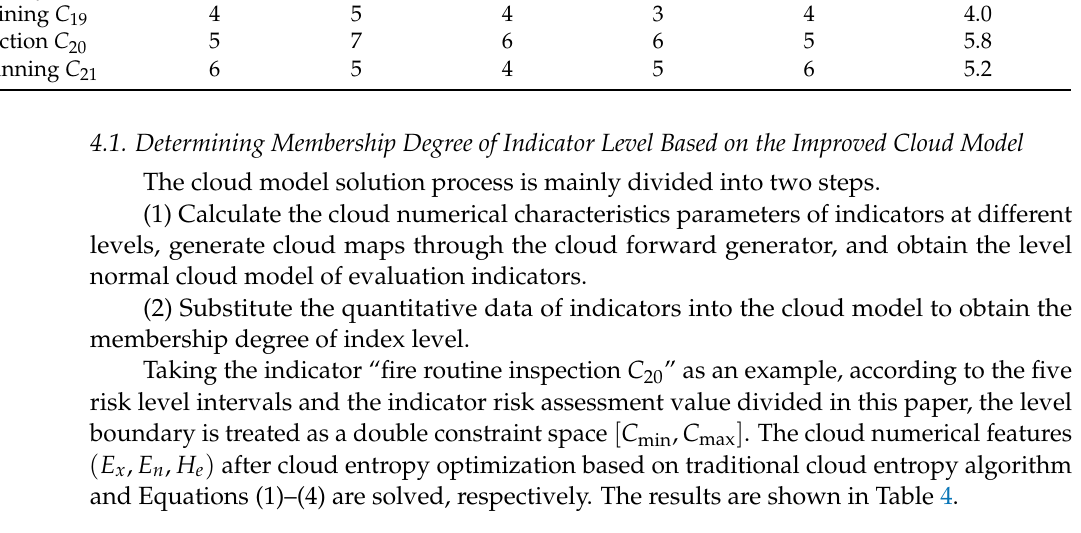
Table 4. Cloud digital characteristic